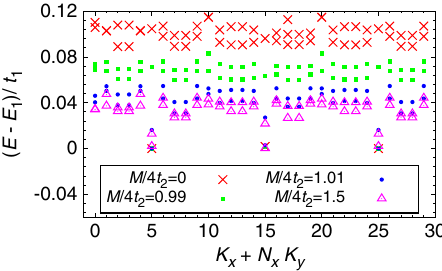
FIG. 14. Low-energy spectrum for different values of M at 5 , and N 6 . We show only the two lowest N ¼ 10 , N x ¼ y ¼ energies per momentum sector. All energies are shifted such that the ground-state energy is 0 for each M